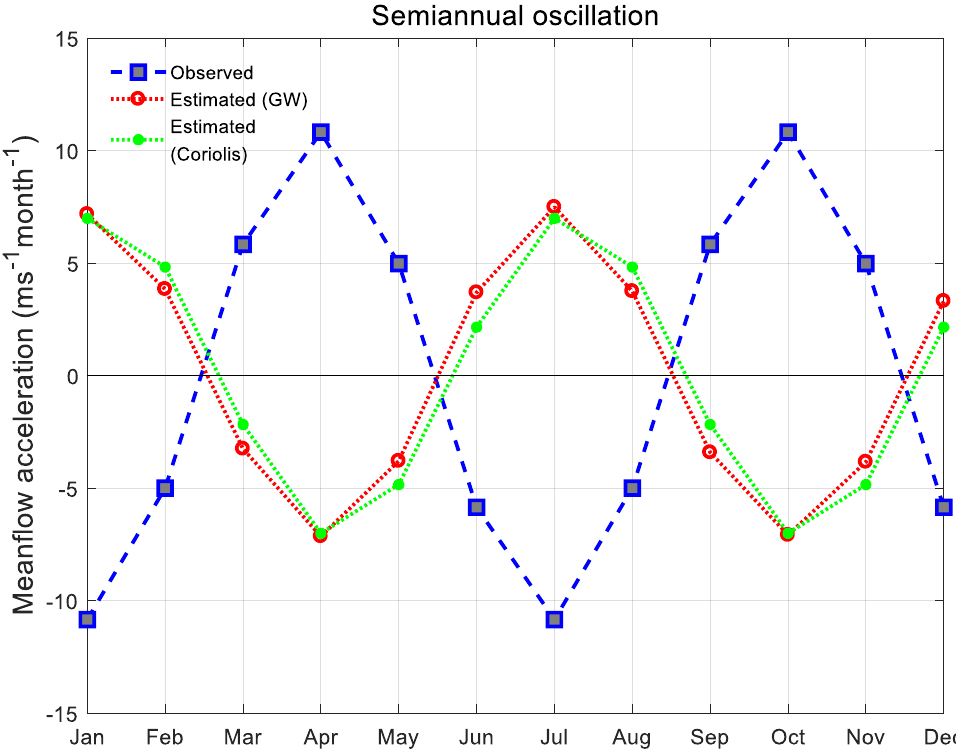
Figure 5. Semiannual oscillation (SAO) components of zonal wind (top), zonal momentum flux (middle), and meridional wind (bottom) at varying altitudes. ( a ) Semiannual oscillation zonal wind; ( b ) Semiannual oscillation vertical flux of zonal momentum; ( c ) Semiannual oscillation meridional wind